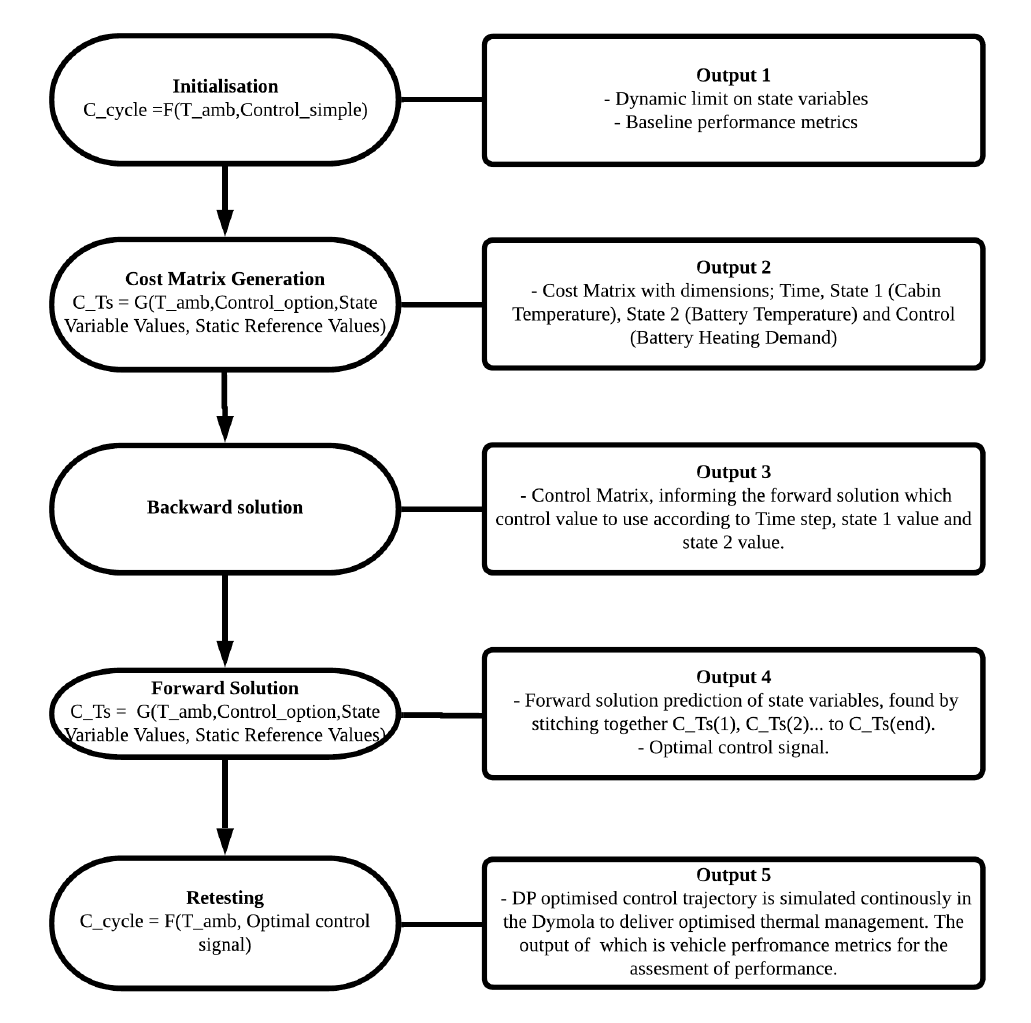
Figure 12. Diagram describing the work flow required to find optimal battery heating